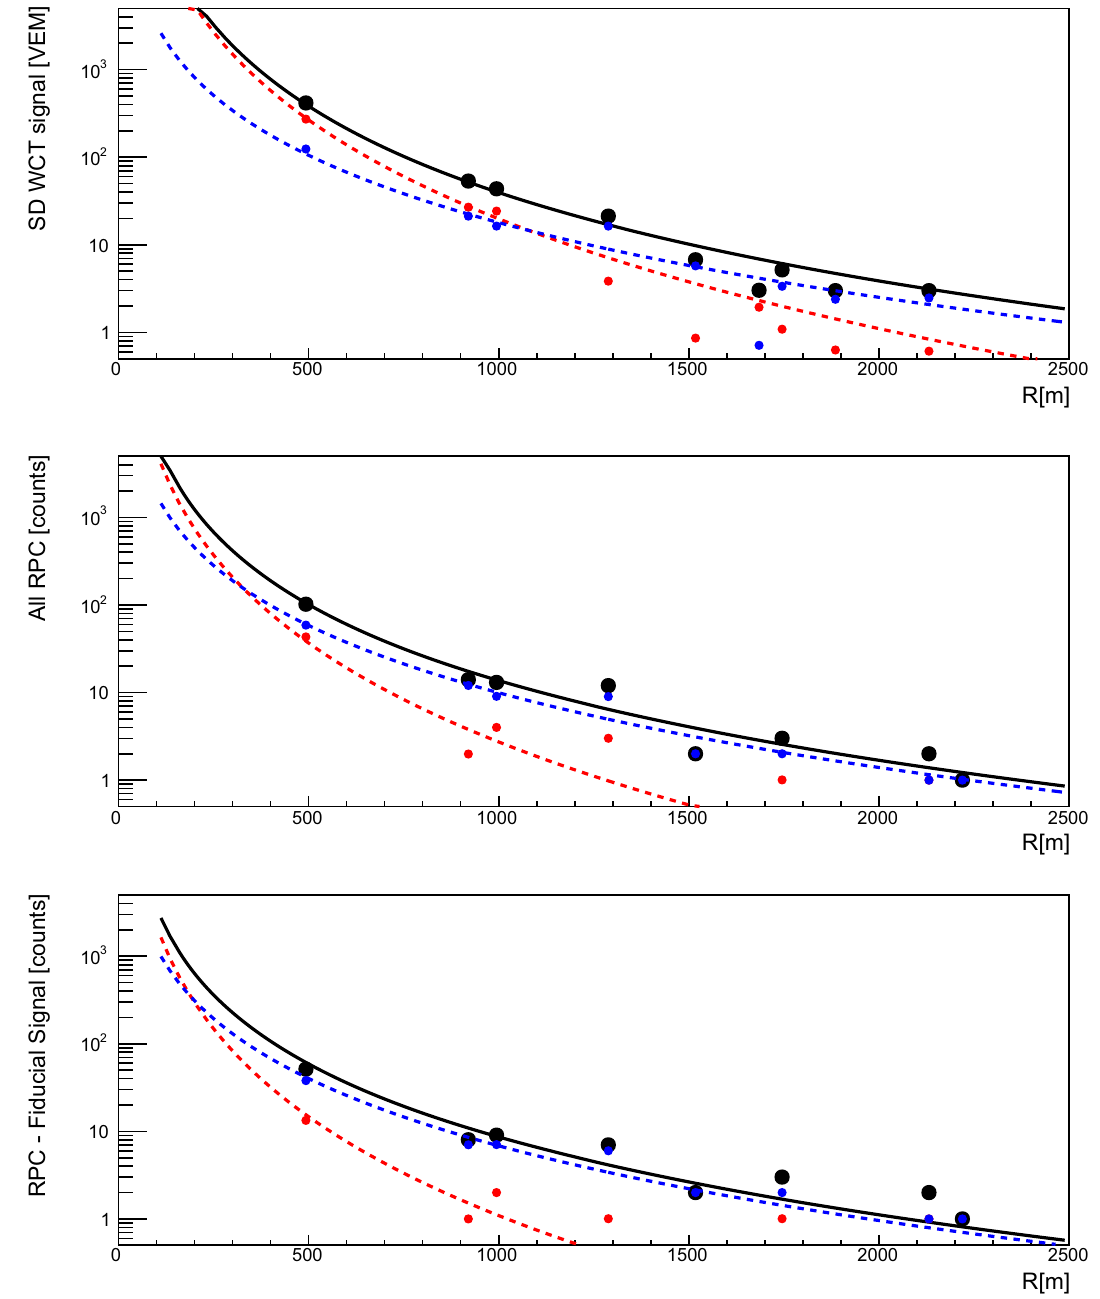
Fig. 12 Combined fit for one event (QGSJET-II.04 proton with θ = 38 ◦ and E = 10 19 eV) in the tank and in the RPC’s total and fidu- cial area. The large black dots are the measurements used in the fit. The black line is the sum of the two dashed lines corresponding to the